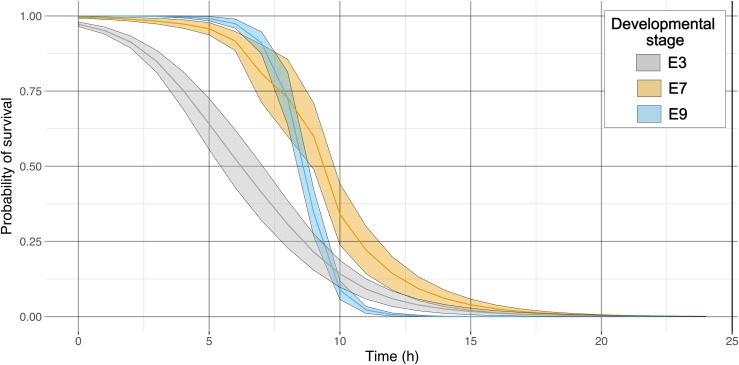
Duration of exposure-dependant probability of survival curves at 36°C for different developmental stages of R. balthica (S3 Data).